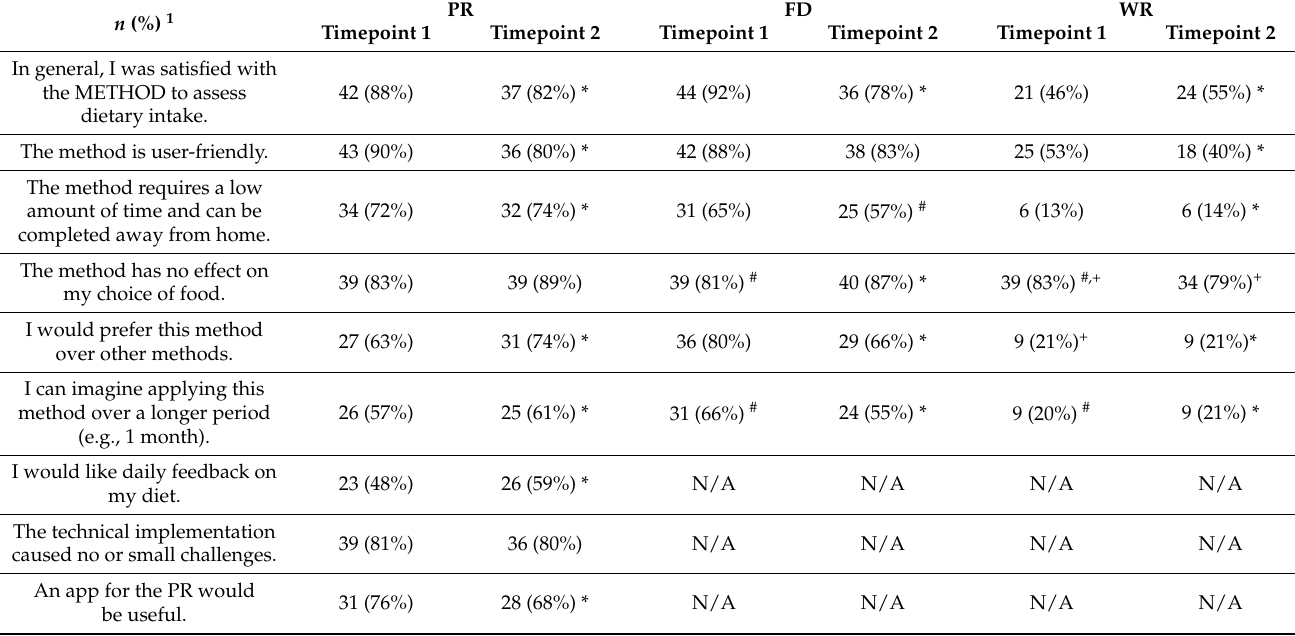
Table 3. Absolute and relative frequencies of participants who (rather) agree to the questions in the satisfaction survey for the different assessment